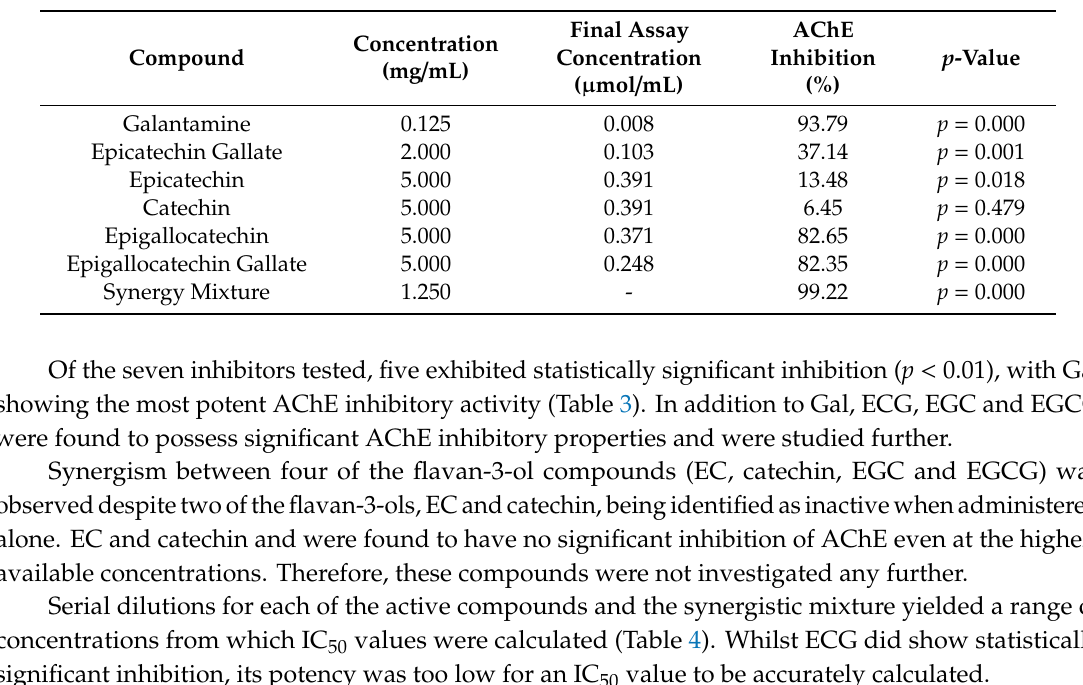
Table 3. AChE inhibition: shows the results for AChE inhibition activity at the highest concentrations available for each compound. Only compounds showing statistically significant levels of inhibition ( p < 0.01) were tested further.